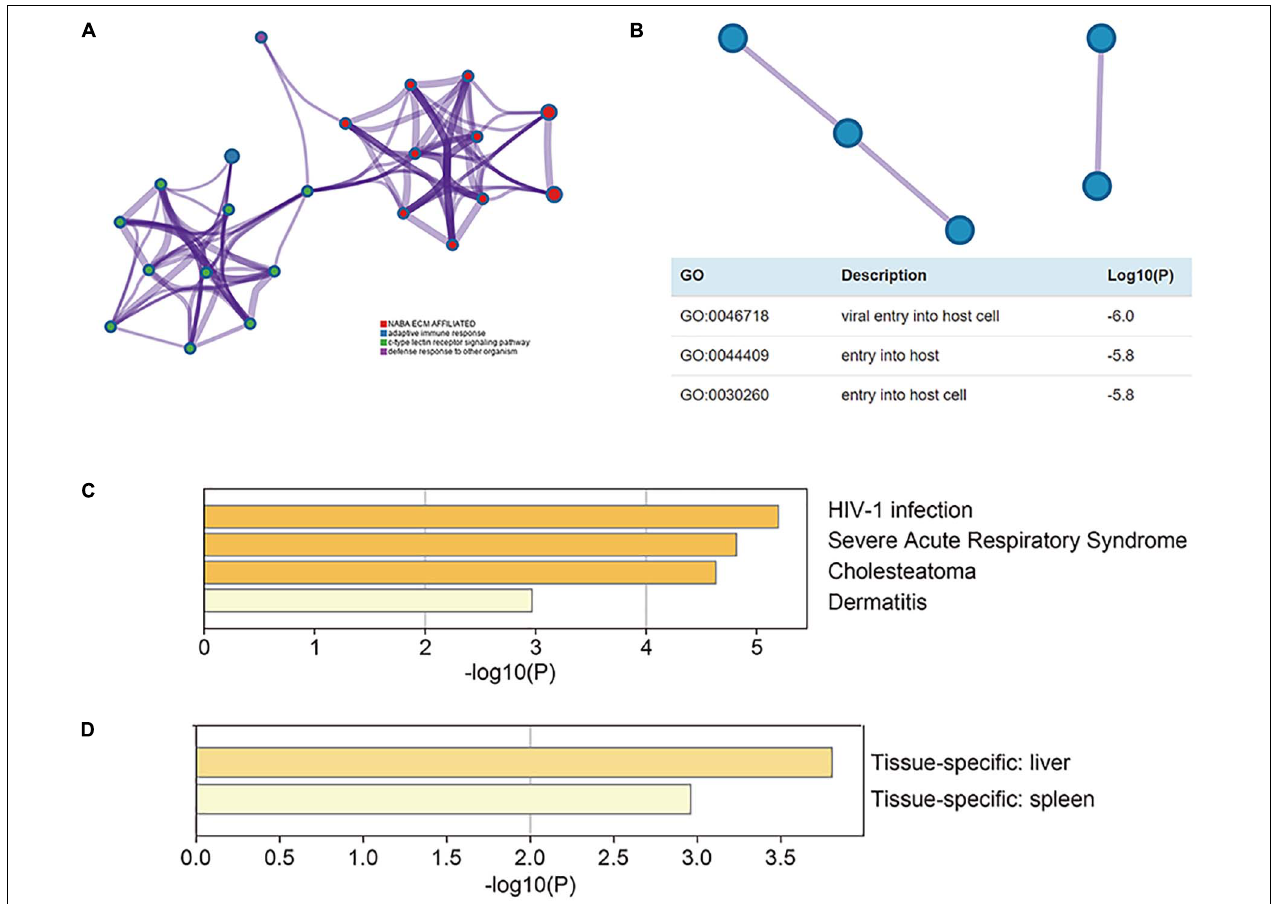
FIGURE 10 | The functional enrichment analysis of CLEC4s. The association of CLEC4s with their neighboring genes analyzed with Cytoscape was shown in (A) and protein-protein interaction evaluated with MCODE was shown in (B) . CLECL4 was involved in HIV-1 infection, severe acute respiratory syndrome, cholesteatoma, and dermatitis (C) . CLEC4s were specific in liver and spleen tissue (D)